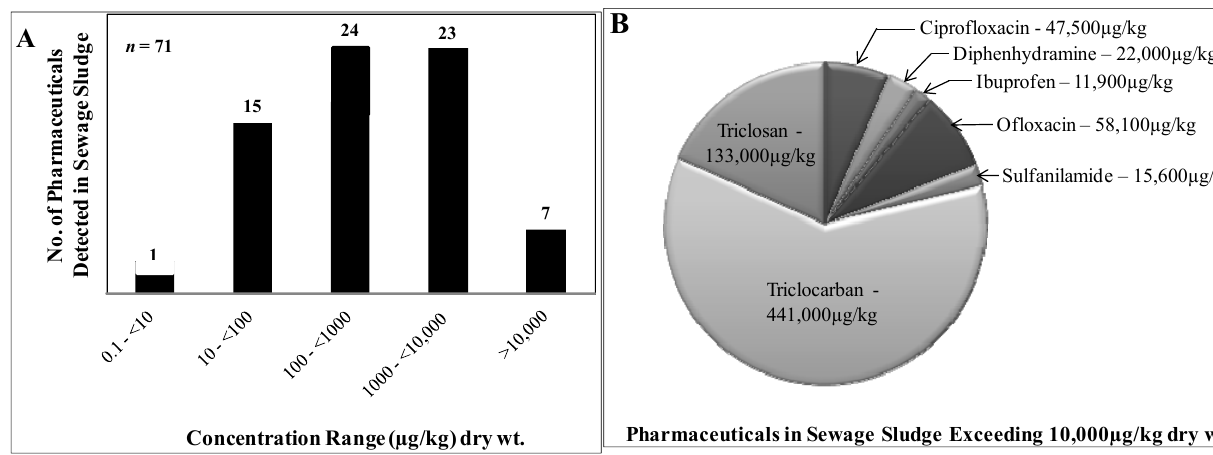
Figure 3. ( A ) Number of pharmaceuticals detected in sewage sludge. Only maximum concentrations of the pharmaceuticals were included and categorized into different concentration ranges; ( B ) Identity and maximum concentrations of pharmaceuticals detected in sewage sludge at concentrations exceeding 10,000 μ g/kg dry